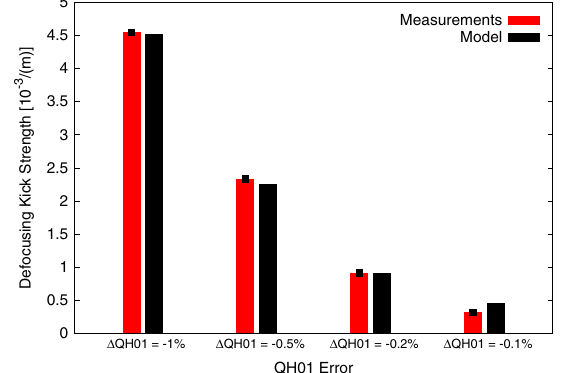
FIG. 4. Two different filling patterns used during the measure- ments. A low charge per bunch filling pattern (top) composed by a train of 45 buckets, each one filled with 0.20 nC each on average. A high charge filling pattern (bottom) composed by only two bunches carrying around 4.4 nC each. Only the first 50 buckets out of the total 448 are shown. The temporal structure of the magnetic kicker field is also shown, displaying a rather flat profile in the region where the bunches are located.